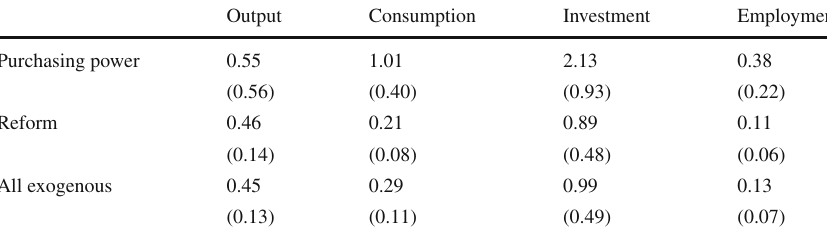
Table 2 The aggregate effect of transfers shocks by